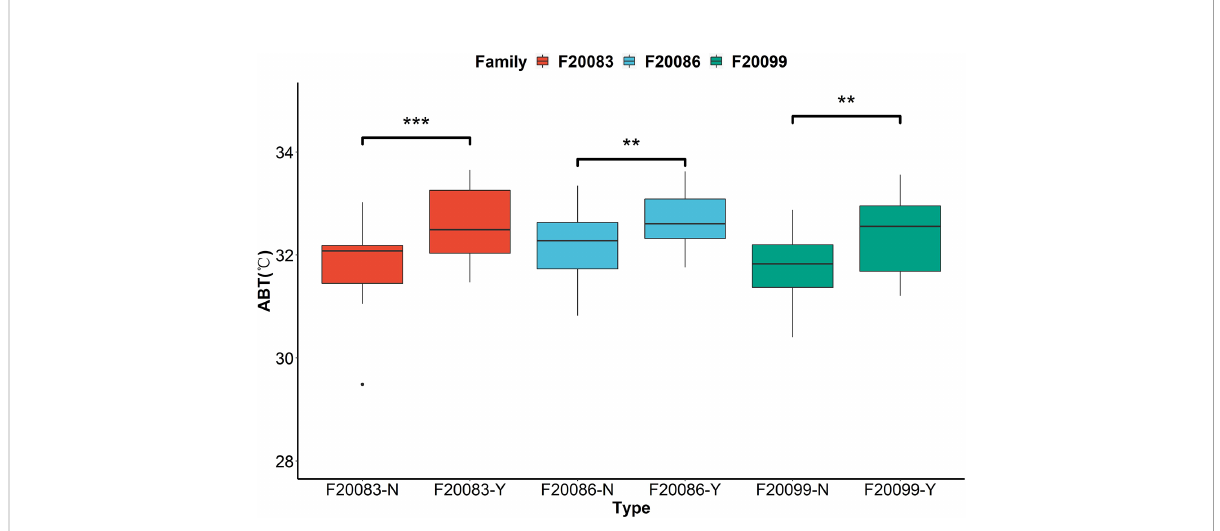
FIGURE 2 The comparisons of thermal tolerance between the individuals with black mantle markings (Y) and individuals without black mantle markings (N) in three families based on the assessment of Arrhenius break temperatures (ABT) of cardiac performance. ** indicates P < 0.01. *** indicates P <